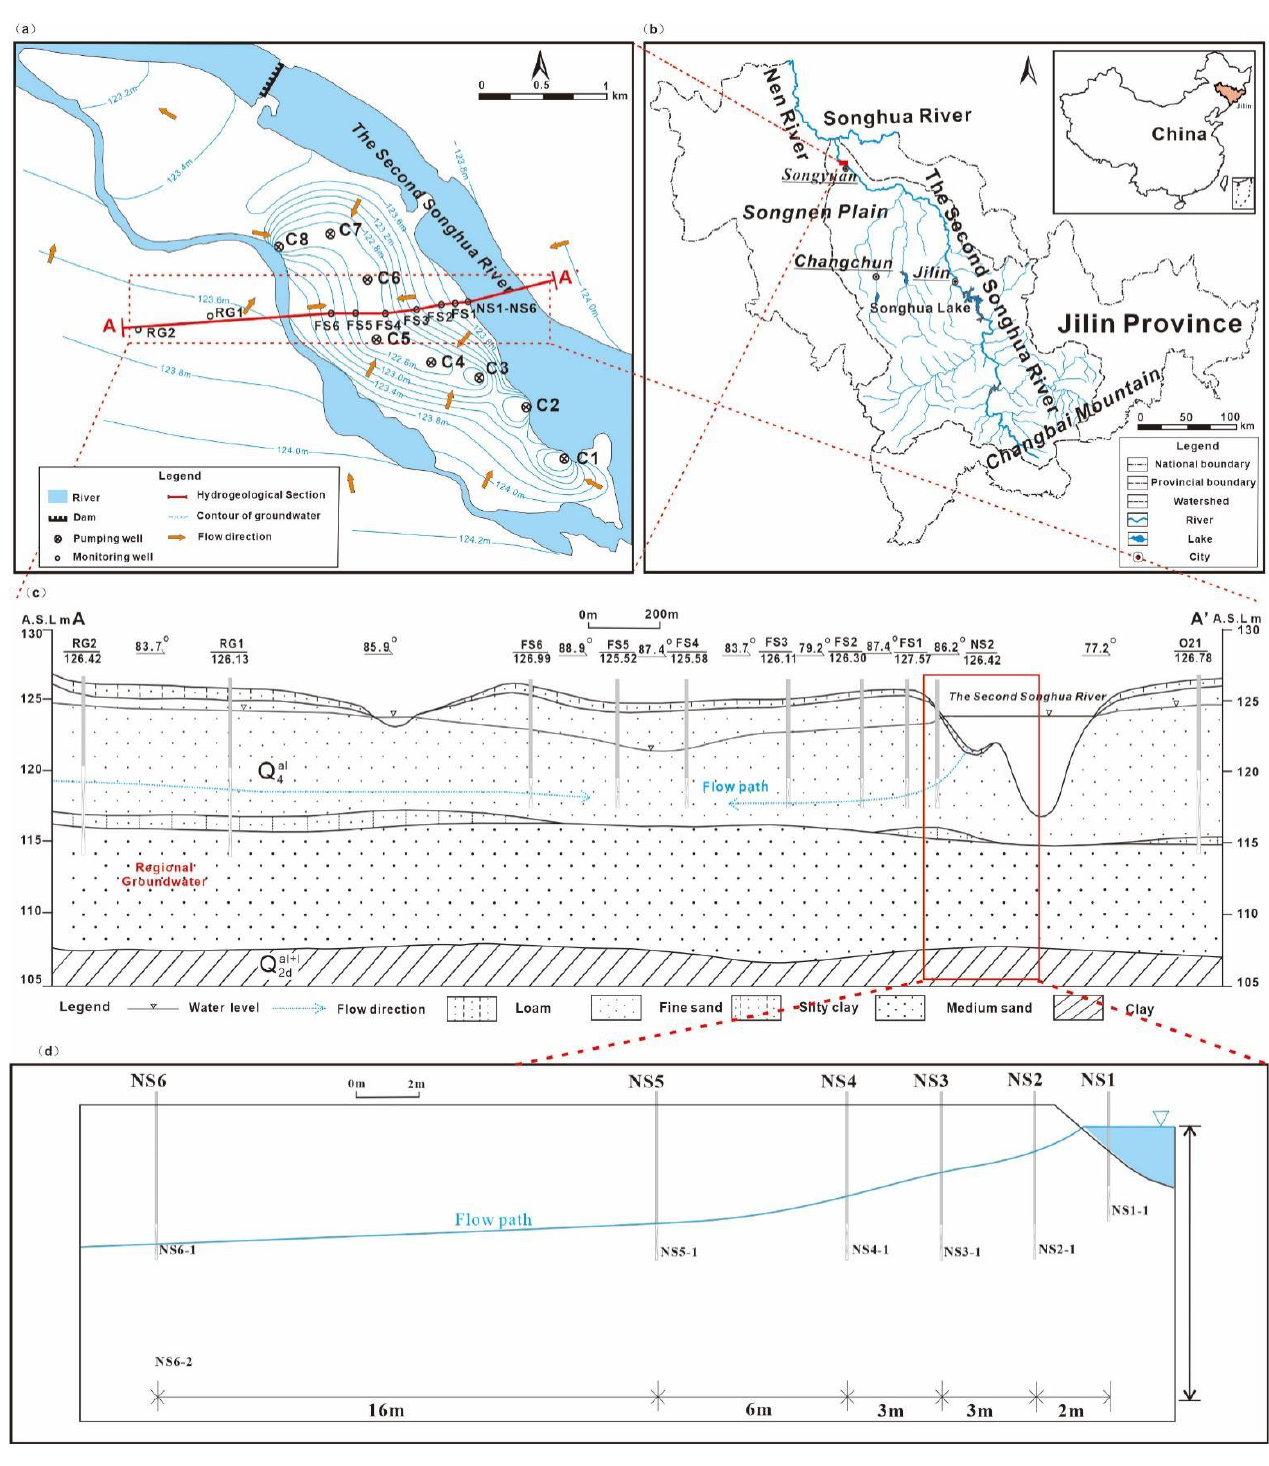
Figure 2. Distribution of wells in the study area ( a ); administrative division of the study area ( b ); flow paths and zone division by the hydrogeology condition ( c ); monitoring wells in the nearshore zone ( d ): modifications of those reported by Su et al. (2020). A-A’ represents the groundwater dynamic monitoring profile that is nearly consistent with the direction of river water infiltration into groundwater